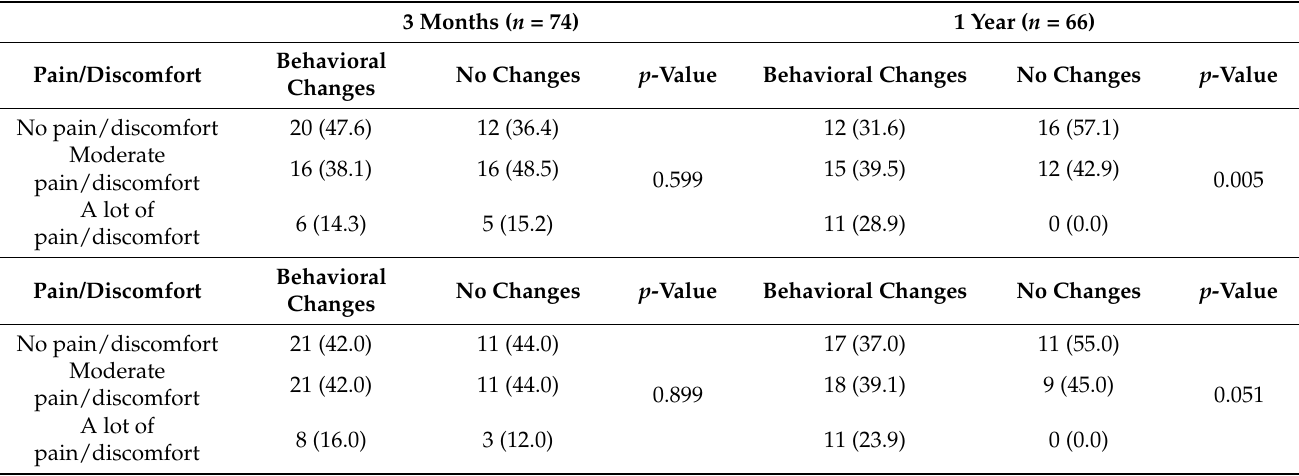
Table 3. Differences in the pain/discomfort dimension of EQ-5D between patients with and without behavioral and lifestyle changes at 3 months and 1 year after